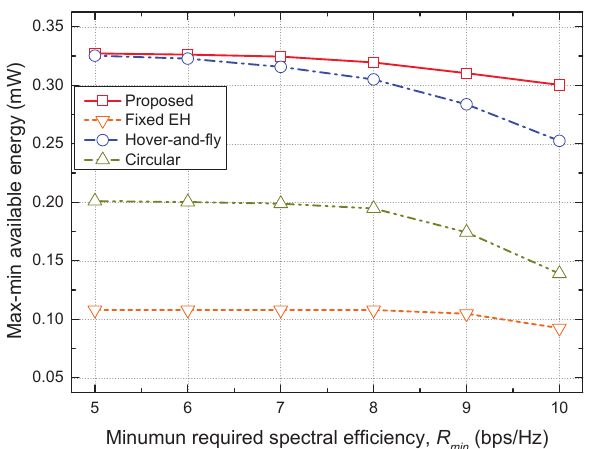
Figure 5. Max-min available energy vs. minimum required spectral efficiency. Figure 5. Max–min available energy vs. minimum required spectral